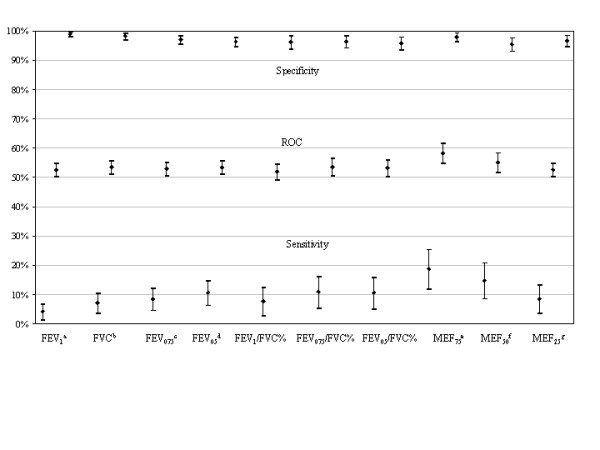
Sensitivity and specificity (and CI95%) versus symptoms in children of reduced function parameters. ROC = Receiver Operating Characteristic. aFVC = forced vital capacity; bFEV1= forced expiratory volume in one second; cFEV0.75 = forced expiratory volume in 3/4 of a second; dFEV0.5 = forced expiratory volume in half a second; eMEF75 = instantaneous expiratory flow when 25% of FVC has to be expired. fMEF50 = instantaneous expiratory flow when 50% of FVC has to be expired. gMEF25 = instantaneous expiratory flow when 75% of FVC has to be expired